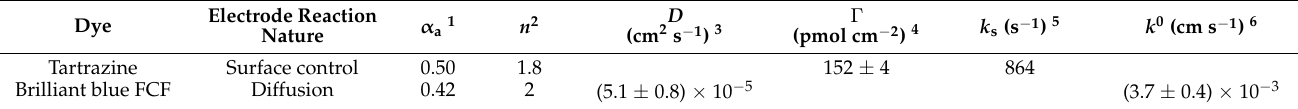
Table 3. Electrooxidation parameters of colorants on the MnO 2 nanorods-modified electrode. Dye Electrode Reaction Nature